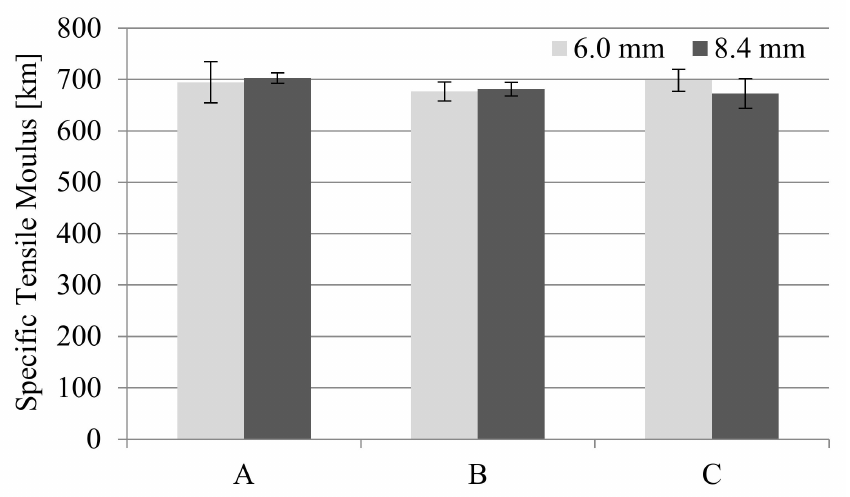
Figure 27. Influence of MuCell ® technology on specific tensile modulus of all the PA66 GF30 samples, where A is a solid sample, while B and C are foamed at 16 and 20 MPa nitrogen pressure respectively.